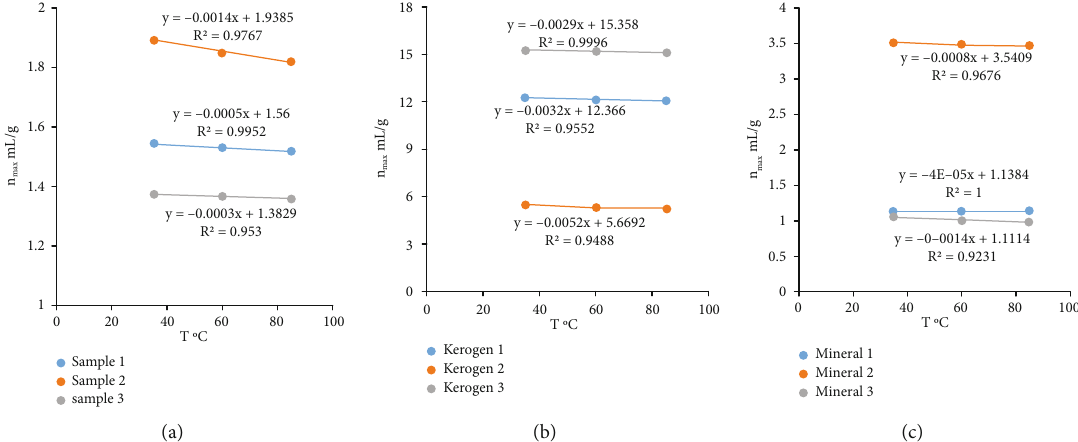
Figure 5: The relationships between Langmuir maximum adsorption capacity of shale (a), kerogen (b), mineral compositions (c), and